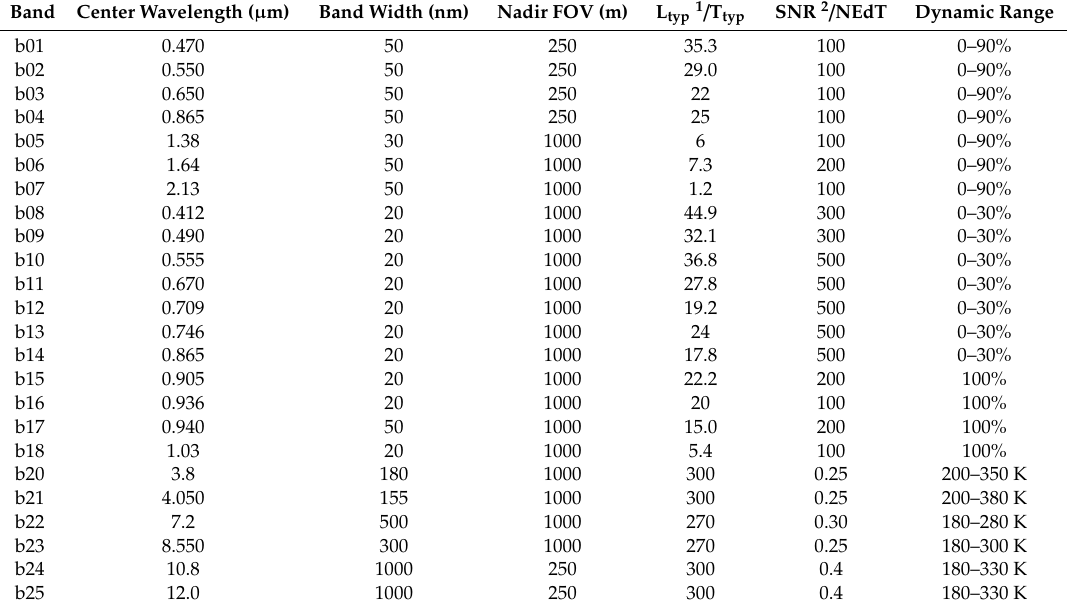
Table 1. Bands and key specifications of the FengYun 3D meteorological satellite (FY-3D) MEdium Resolution Spectral Imager